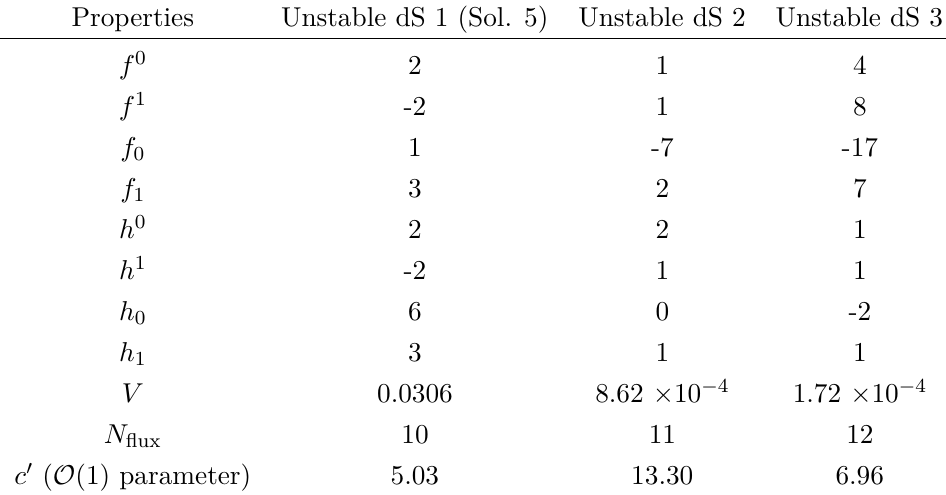
Table 6 . The O (1) parameter of the refined dS conjecture at three unstable dS